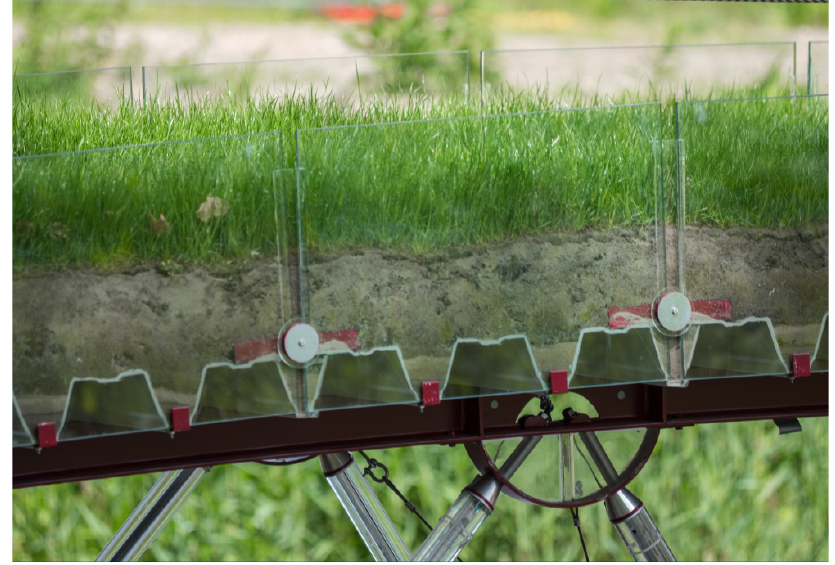
Fig. 4 Photo of detail of the glass truss bridge showing